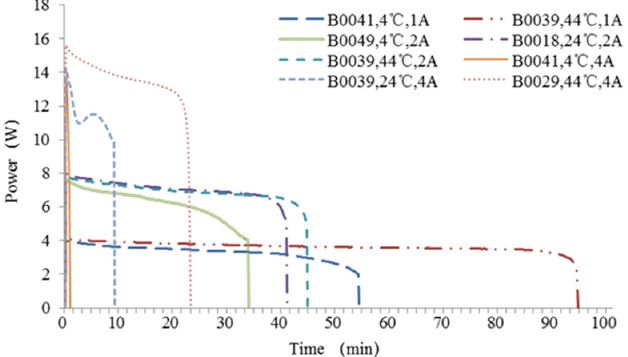
Figure 1. Battery discharging characteristics at different temperatures and currents.